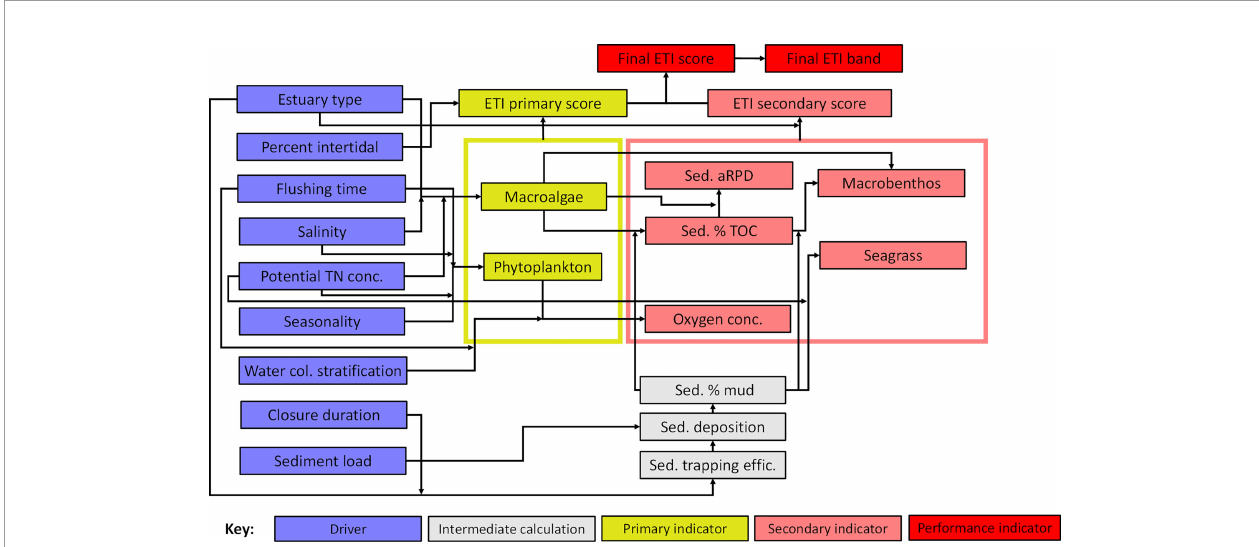
FIGURE 1 | Schematic of the ETI Tool 3 BBN. Information on ‘ drivers ’ (blue nodes) are input by the user and the BBN calculates values of primary and secondary trophic indicators (yellow and pink ‘ indicator ’ nodes). Primary and secondary indicator values are used to produce ETI primary and secondary indicator scores, which are then combined to give the fi nal ETI ‘ performance ’ score and band (red nodes). To simplify the schematic, yellow and pink rectangles indicate ‘ standardisation nodes ’ that normalise values of indicators prior to input to primary and secondary score nodes (see standardised indicator node section